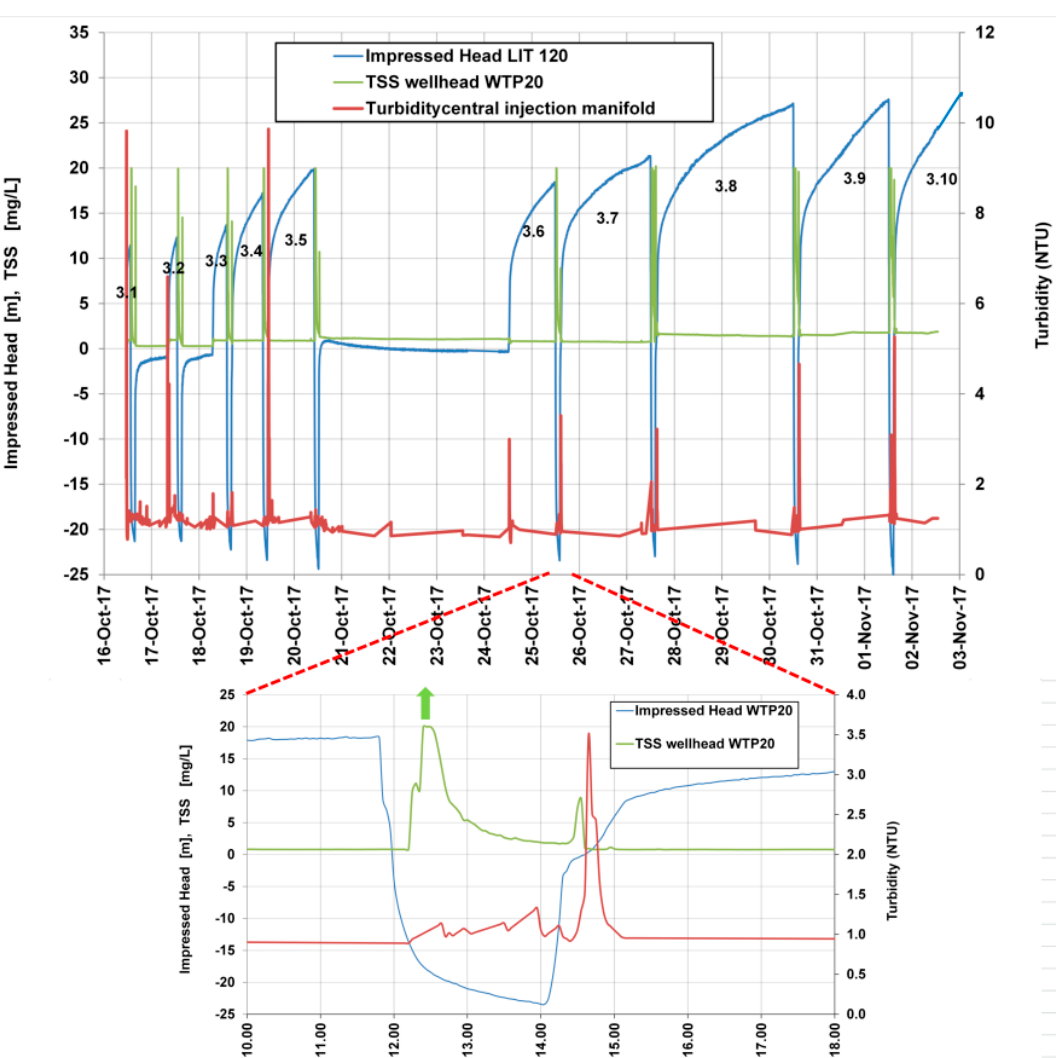
Figure 3. Impressed head/drawdown, total suspended solids ( TSS , at well head) and turbidity (in central injection manifold) for ASR well 20, during ASR Cycle 3A (with 10 sub-cycles divided by backflush events), with zooming in on 25 October 2017 10–18 h. Note the TSS cut-off at 20 mg/L, and the logarithmic increase of impressed head.